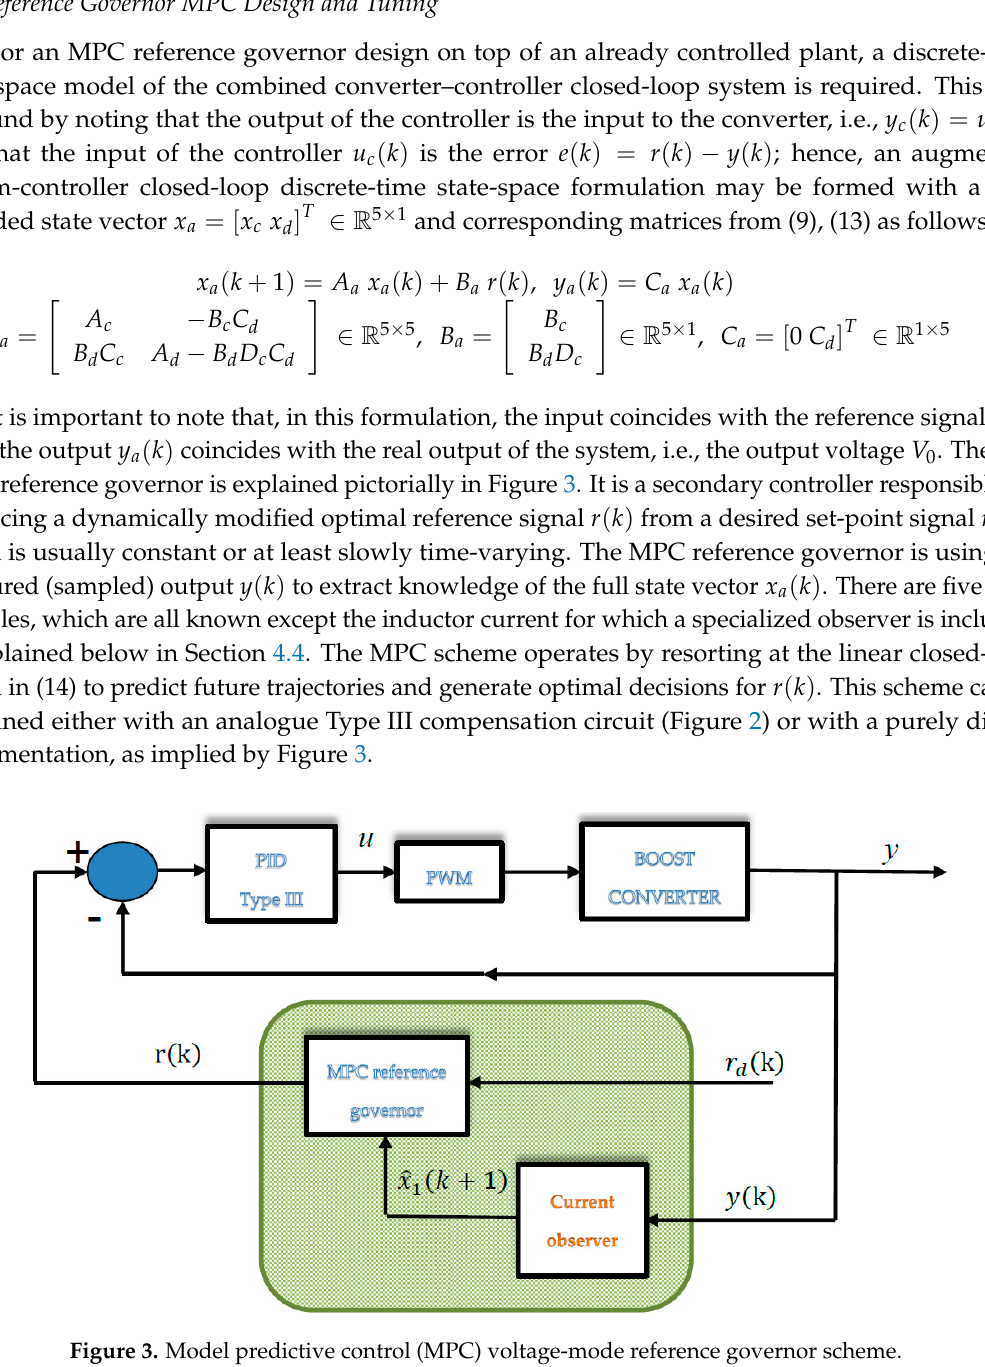
Figure 3. Model predictive control (MPC) voltage-mode reference governor scheme.